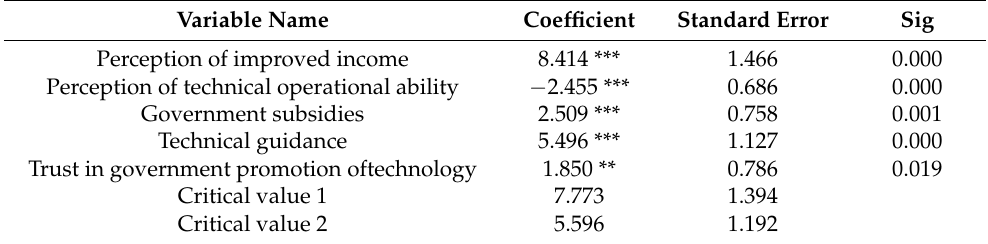
Table 8. Estimation result of farmers’ willingness to adopt healthy crop growth technology.